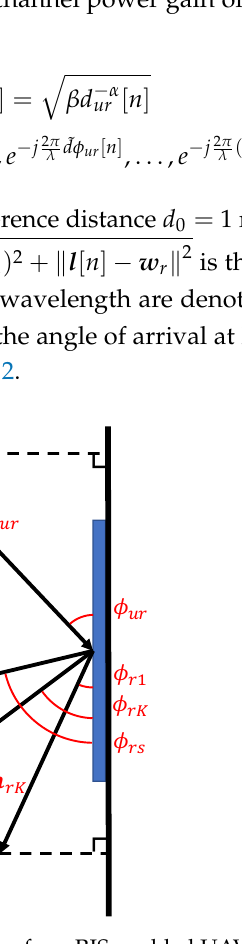
Figure 2. The geometrical diagram for a RIS-enabled UAV CR communication